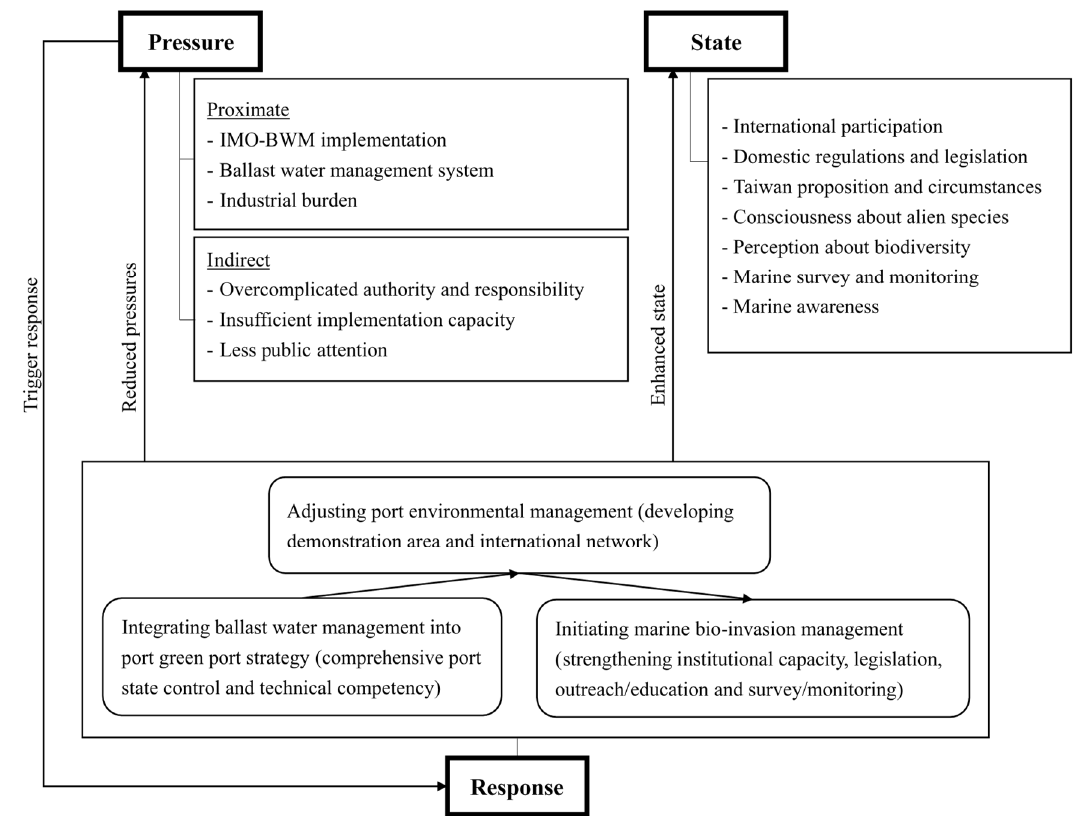
Figure 2. Interplay of the pressure–state–response conceptual model based on grounded theory.